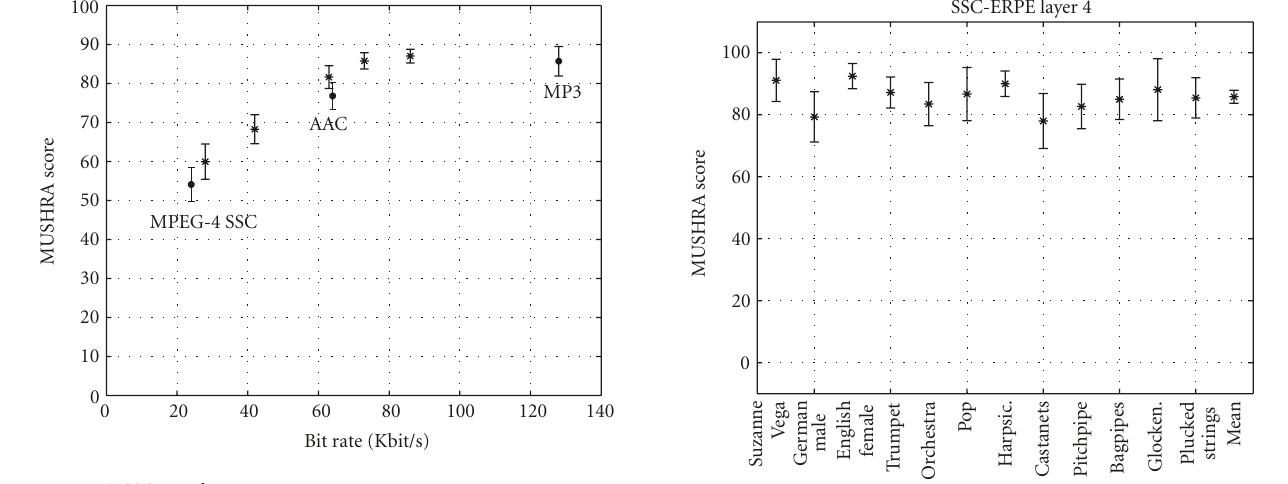
Figure 15: Listening test results per excerpt for SSC-ERPE Layer 4 (73Kbit/s